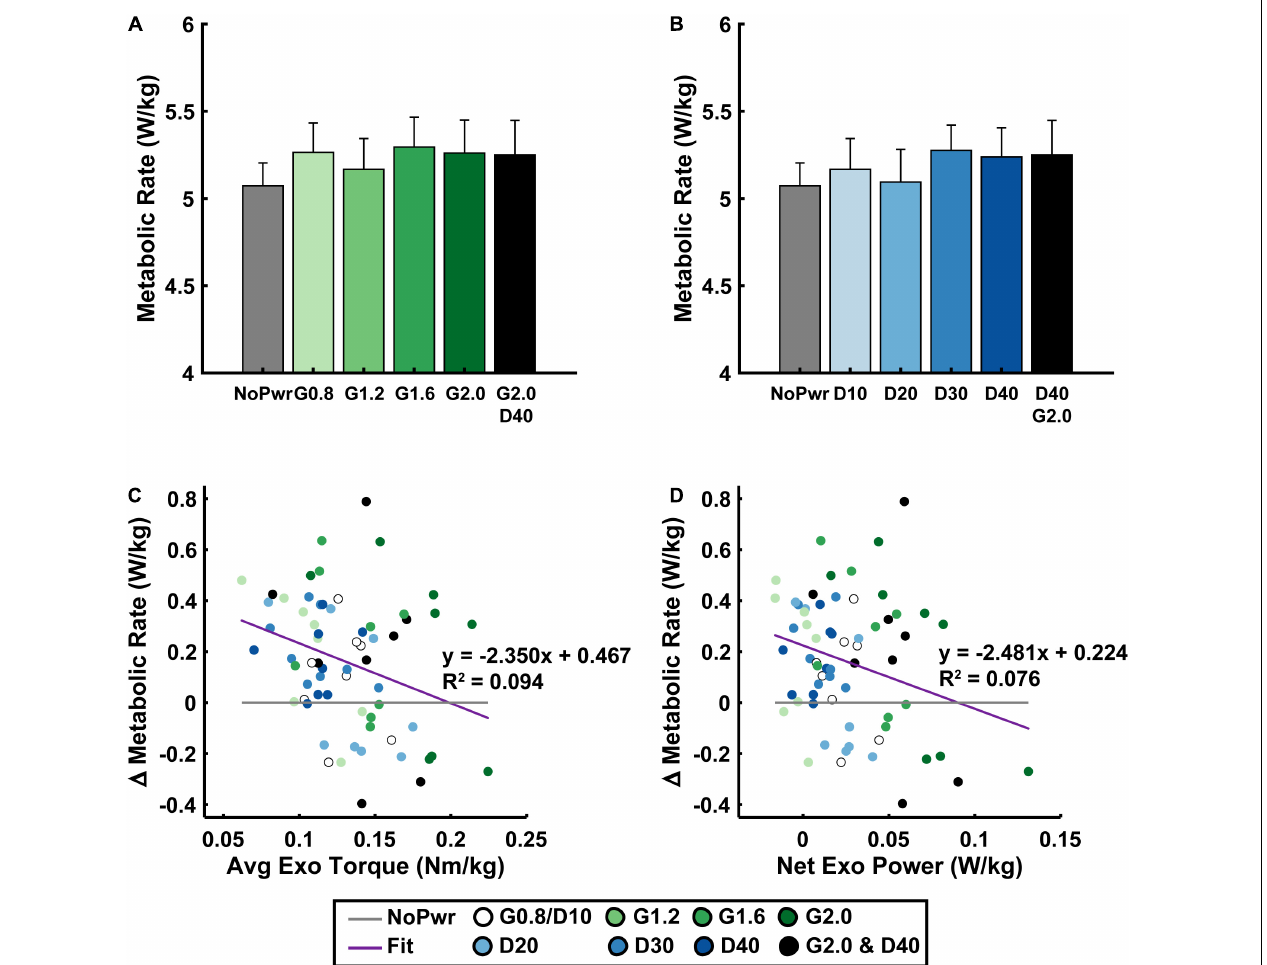
FIGURE 4 | Users’ metabolic rate. Average ( ± S.E.M., N = 9 participants) metabolic rate across NMM reflex Gain (green) (A) and Delay (blue) (B) conditions. Linear regressions between the change in metabolic rate versus the change in average exoskeleton torque with respect to the unpowered (NoPwr) condition (C) and the change in metabolic rate versus the change in net exoskeleton power with respect to the unpowered (NoPwr) condition (D) . * denotes pairwise significant difference with p < 0.05. R 2 values are denoted with a “ ∼ ” if the linear regression was not statistically significant. Conditions are abbreviated and color coded as follows: unpowered (NoPwr) (gray), NMM reflex Gains of 0.8, 1.2, 1.6, and 2.0 all with reflex Delay = 10 ms (G0.8, G1.2, G1.6, and G2.0, respectively) (green), NMM reflex Delays of 10, 20, 30, and 40 ms all with a reflex Gain = 1.2 (D10, D20, D30, D40, respectively) (blue), and a high-Gain-high-Delay condition (G2.0 D40)